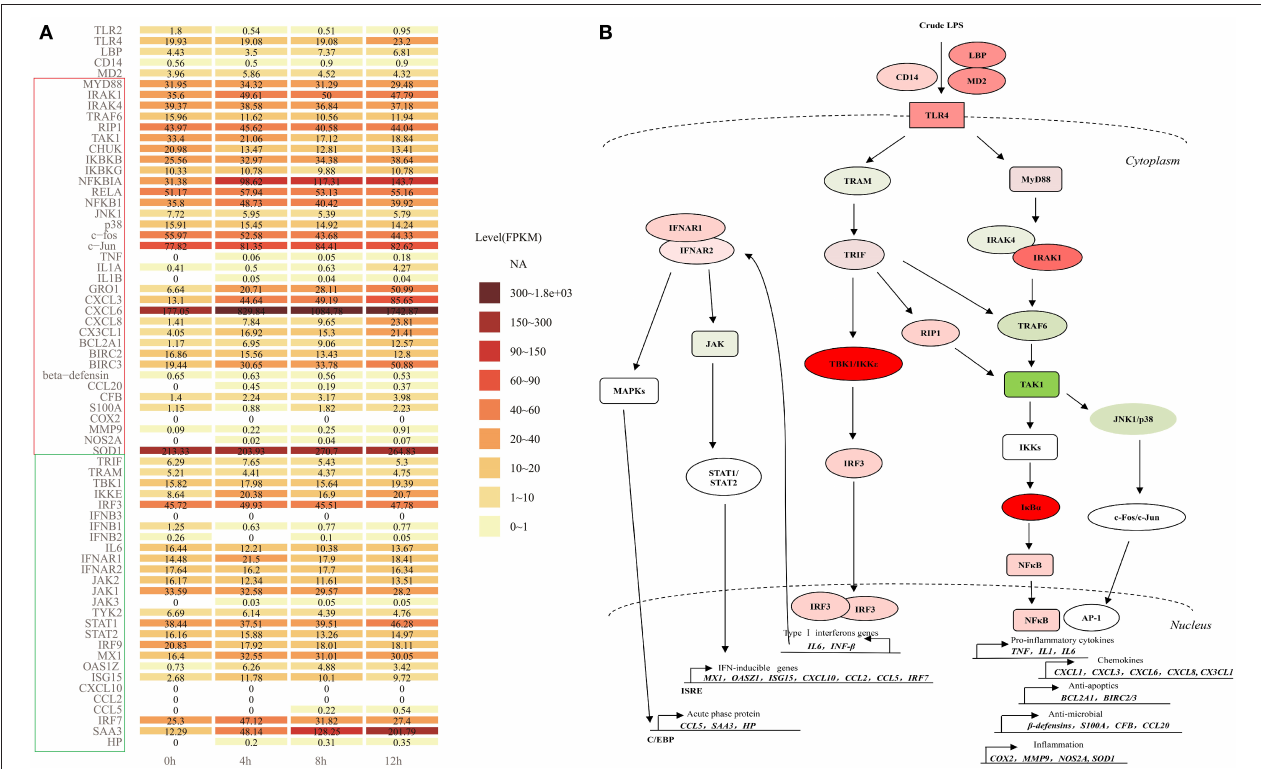
FIGURE 9 | The TLR4 signaling cascades in LPS-induced bMECs. (A) The expression level (FPKM) of all members involved in myeloid differentiation factor 88 (MyD88)-dependent and independent pathway in LPS-induced bMECs; (B) TLR4 signaling following MyD88- dependent and independent pathways. First, signaling via MyD88 subsequently recruits IRAK1, IRAK4 (IL1R associated kinase family), and TNF receptor-associated factor 6 (TRAF6), forms a complex with TAK1 (mitogen-activated protein kinase kinase kinase 7, MAP3K7), then activate TAK1, which phosphorylates I κ B kinases (IKKs, IKK1/IKK2/NEMO complex) and MAP kinases (e.g., JNK, p38). TAK1 can also be induced by receptor-interacting protein 1 (RIP1). IKKs phosphorylate the I κ B α , then leads to I κ B α degradation, enabling the nuclear translocation of NF κ B, ultimately beginning the transcription activation of pro-inflammatory cytokines (TNF α , IL1, and IL6), chemokines (GRO1, CXCL3, CXCL6, CXCL8, and CX3CL1), anti-apoptotic genes (BCL2A1 and BIRC2/3), anti-microbial genes ( β -defensins, S100A, CFB, and CCL20) and inflammatory genes (COX2, MMP9, SOD, and NOS2A). Another pathway AP-1 transcription factor formed by c-Fos and c-Jun can be activated by JNK1/p38 complex, then initiate